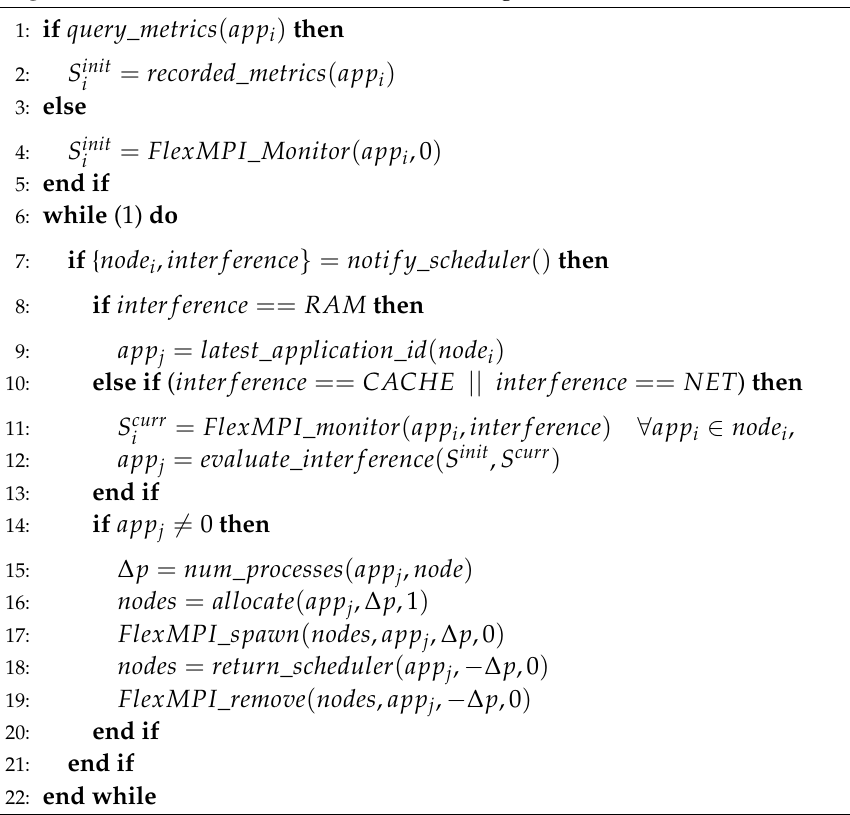
Algorithm 3 CLARISSE interference-aware